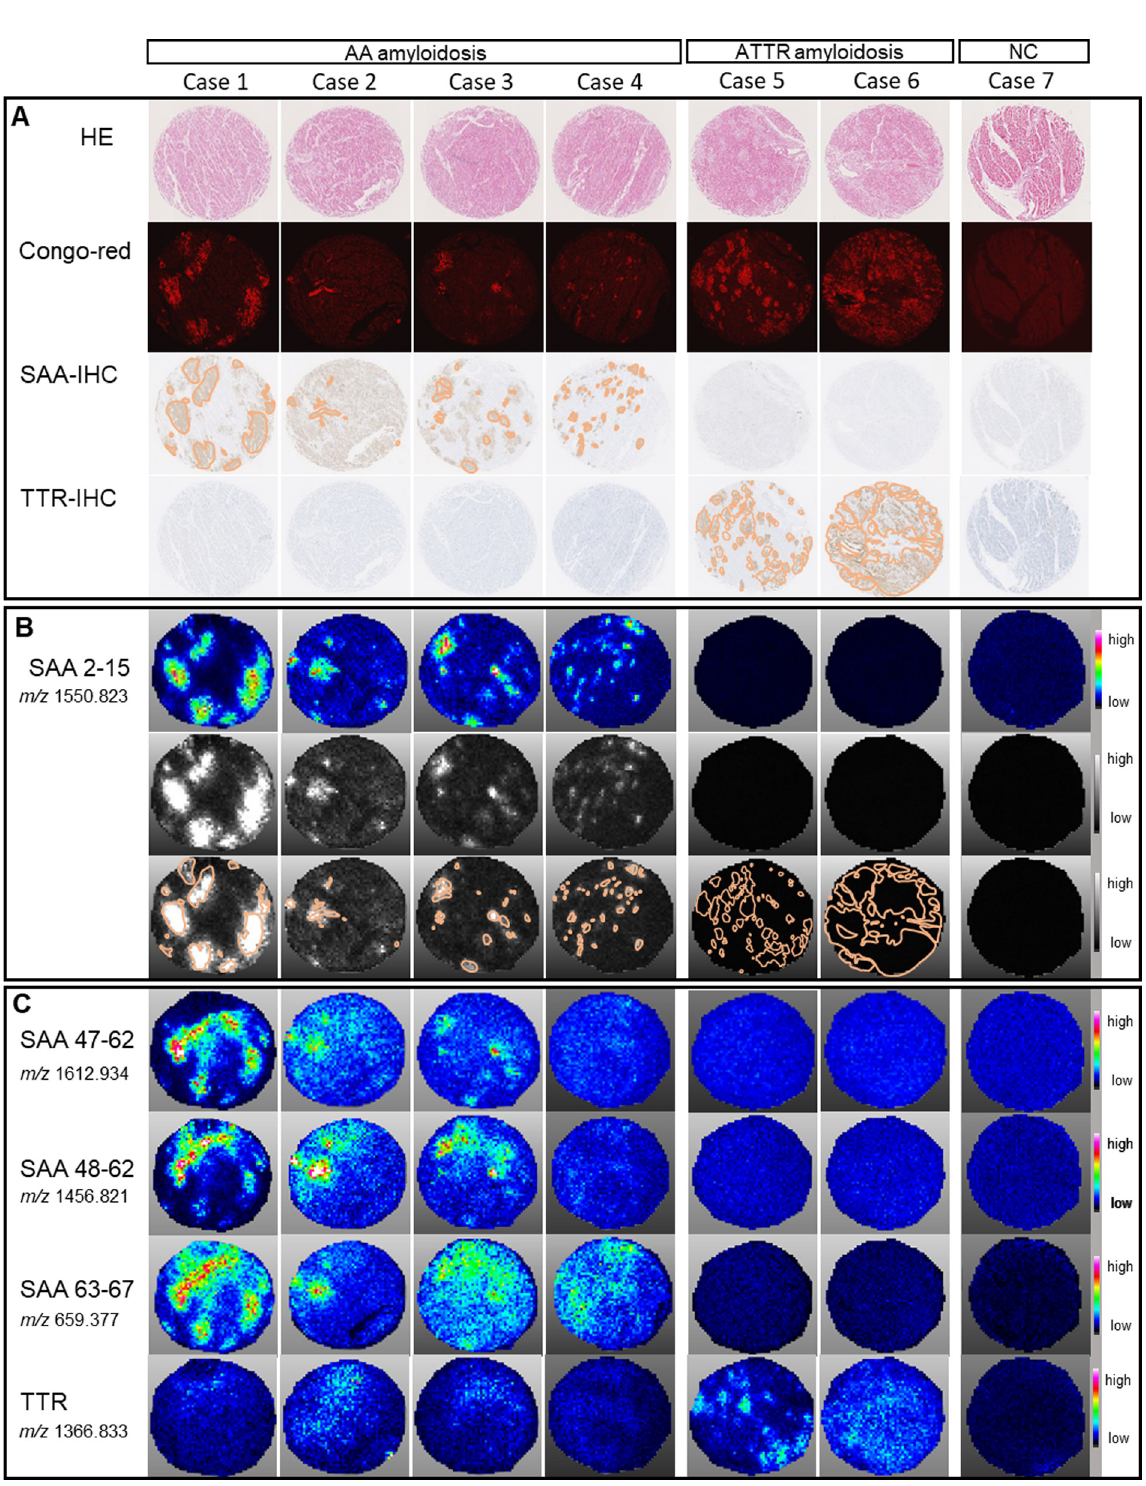
Fig 2. Serum Amyloid A (SAA) 2–15 is specifically localized to amyloid deposits in cardiac tissue of AA amyloidosis. A. From the upper panel, hematoxylin and eosin staining, Congo red staining, and immunohistochemistry (IHC) of SAA and transthyretin (TTR) were superimposed by tracing of Congo red-positive regions. B. Ion images of SAA 2–15 ( m/z 1550.823) in AA amyloidosis (Case 1–4), ATTR amyloidosis (Cases 5 and 6), and normal control (Case 7). The three panels consist of color displays of ion images (upper), gray scale display (middle), and gray scale display superimposed by tracing of Congo red-positive regions (lower). The intensity range is given for each ion